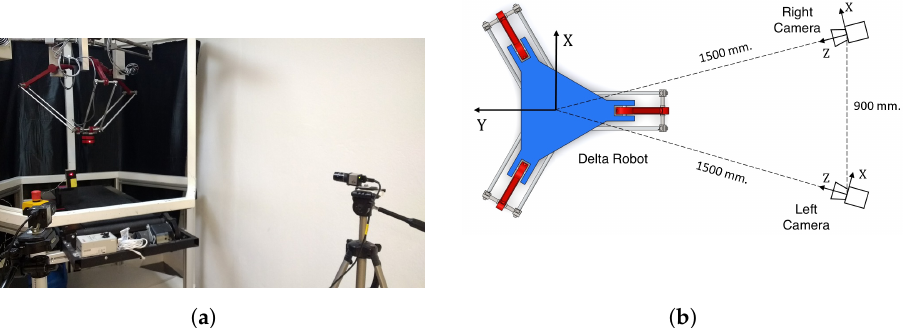
Figure 3. Experimental setup. ( a ) Delta PARALLIX LF-2040 and camera setup. ( b ) Delta robot and camera position scheme.